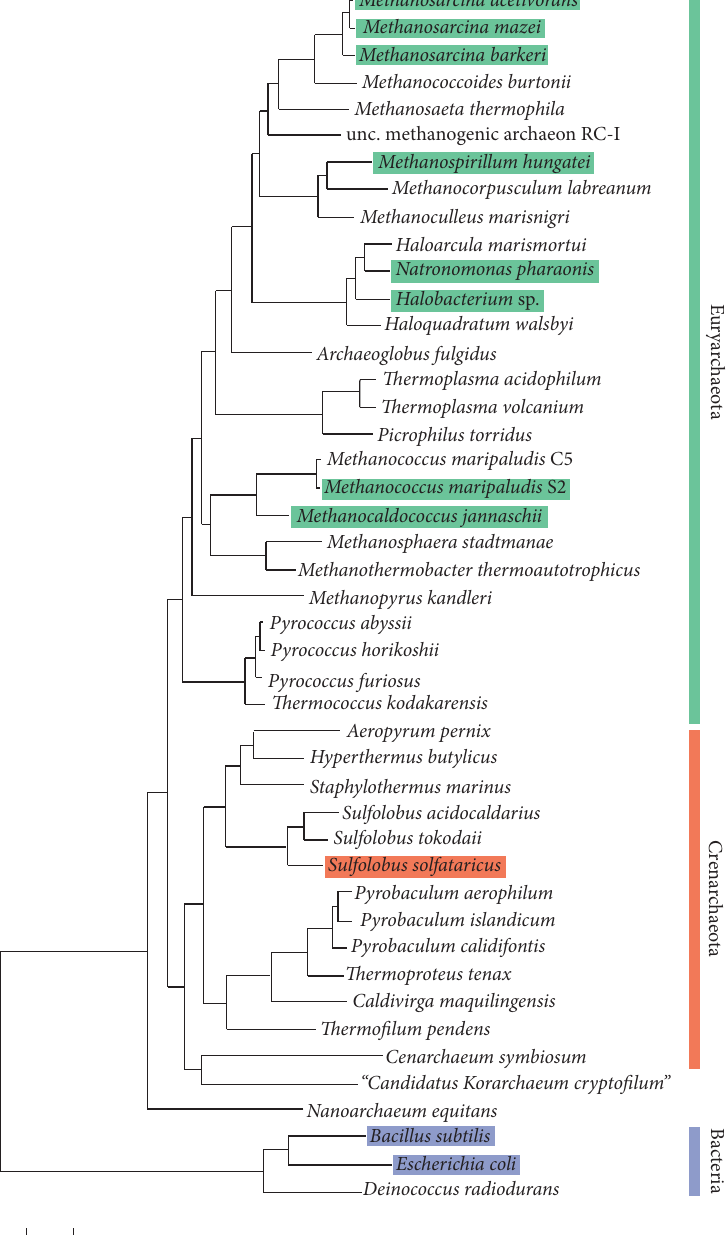
Figure1:Diversityofarchaealmodels.Avisualizationofthediversityofarchaealgenome-scalemetabolicmodelsasrelatedbyphylogeny.The figure is adapted from Elkins et al. [27] where the maximum-likelihood tree was constructed using 33 conserved ribosomal proteins and three largest RNA polymerase subunits. Highlighted species indicate that genome-scale metabolic models have been constructed for that organism. Although not shown in this adapted figure, a Methanobrevibacter smithii model within the Euryarchaeota has also been constructed. While numerous models have been constructed for Euryarchaeota, the Crenarchaeota are severely